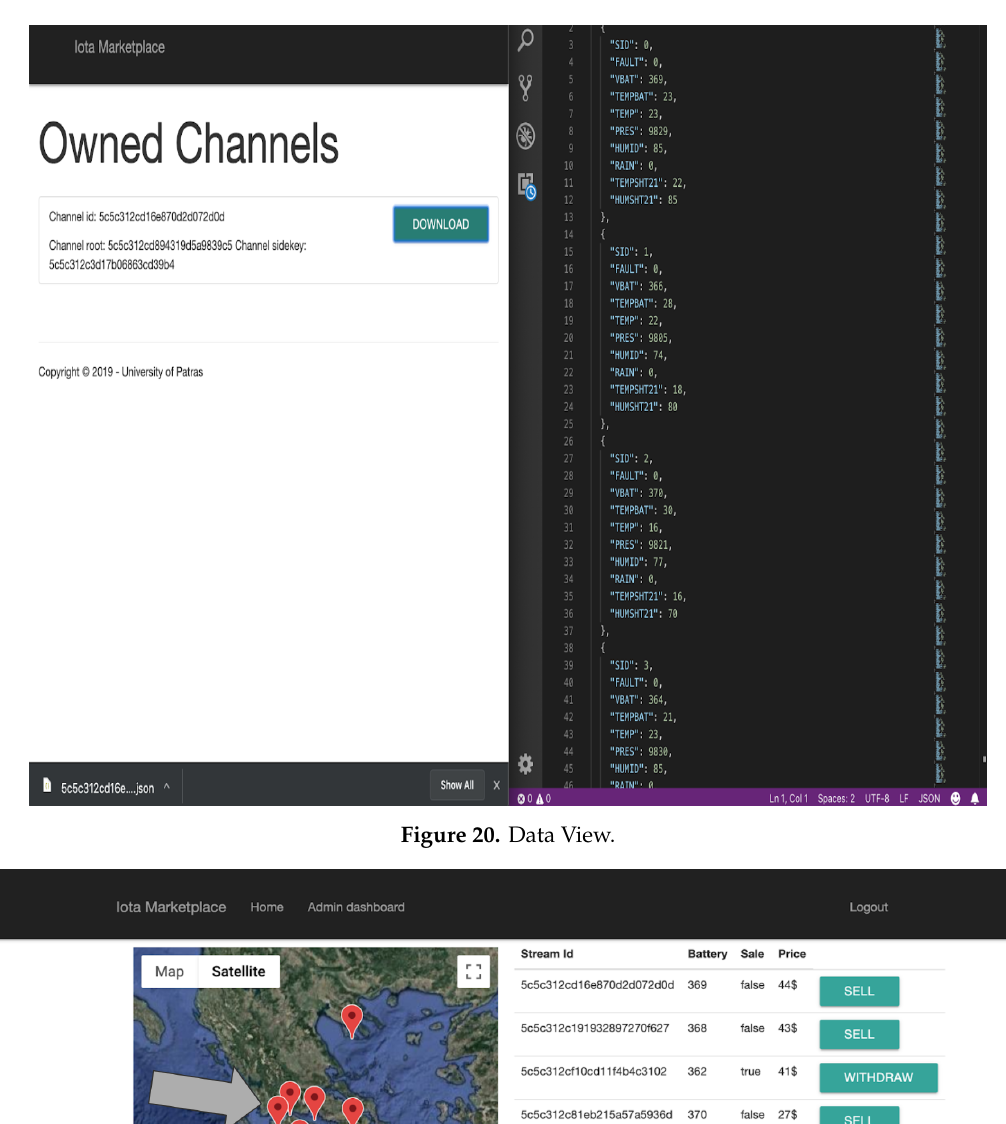
Figure 21. The system administrator can overview the data channels and select those to be available in the